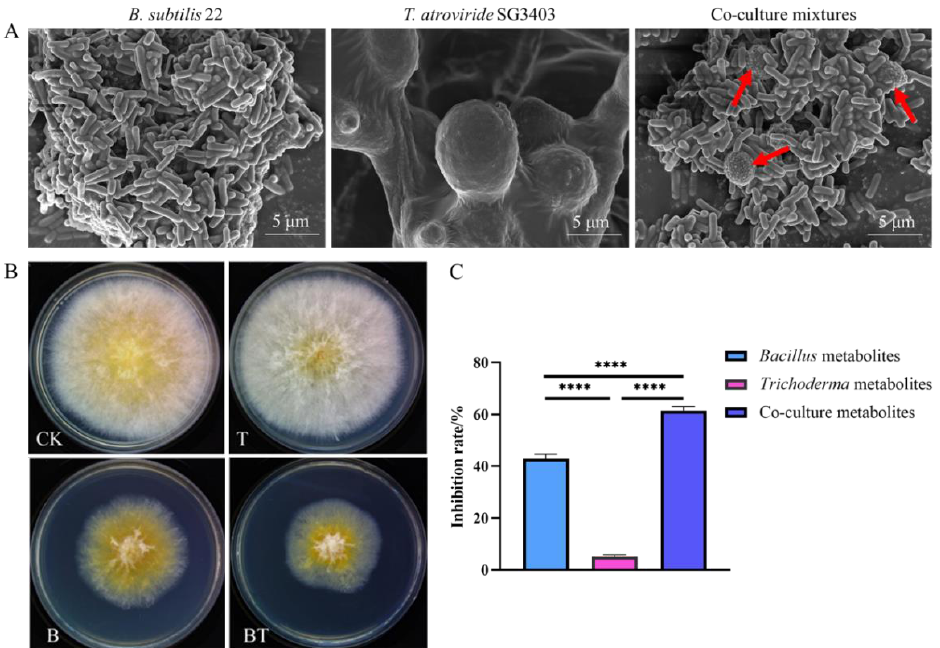
Figure 1. Compatible interaction of B. subtilis and T. atroviride and effect of the co-culture filtrate of B. subtilis and T. atroviride on F. gramiearum growth. ( A ) SEM results with respect to the co-culture interaction; the red arrow denotes the mycelia of T. atroviride . ( B ) Inhibitory effects of the co-culture and axenic culture metabolites on F. graminearum . B denotes axenic culture metabolites of B. subtilis ; T denotes axenic culture metabolites of T. atroviride ; BT denotes co-culture metabolites. ( C ) Inhibitory rates of the co-culture and axenic culture metabolites on F. graminearum . The significance of the difference between the axenic and co-culture metabolites was p = 0.001. **** p ≤ 0.001.